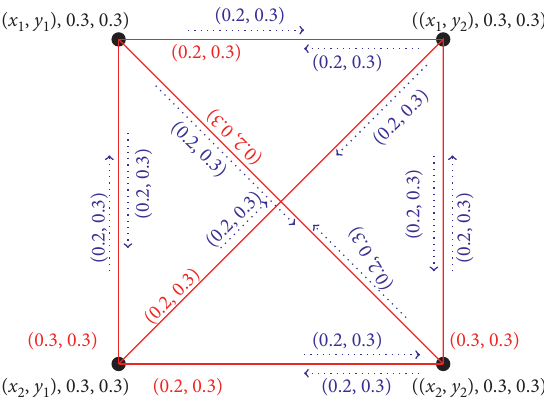
Figure 14: NP of IFIGs provided in Figures 12 and